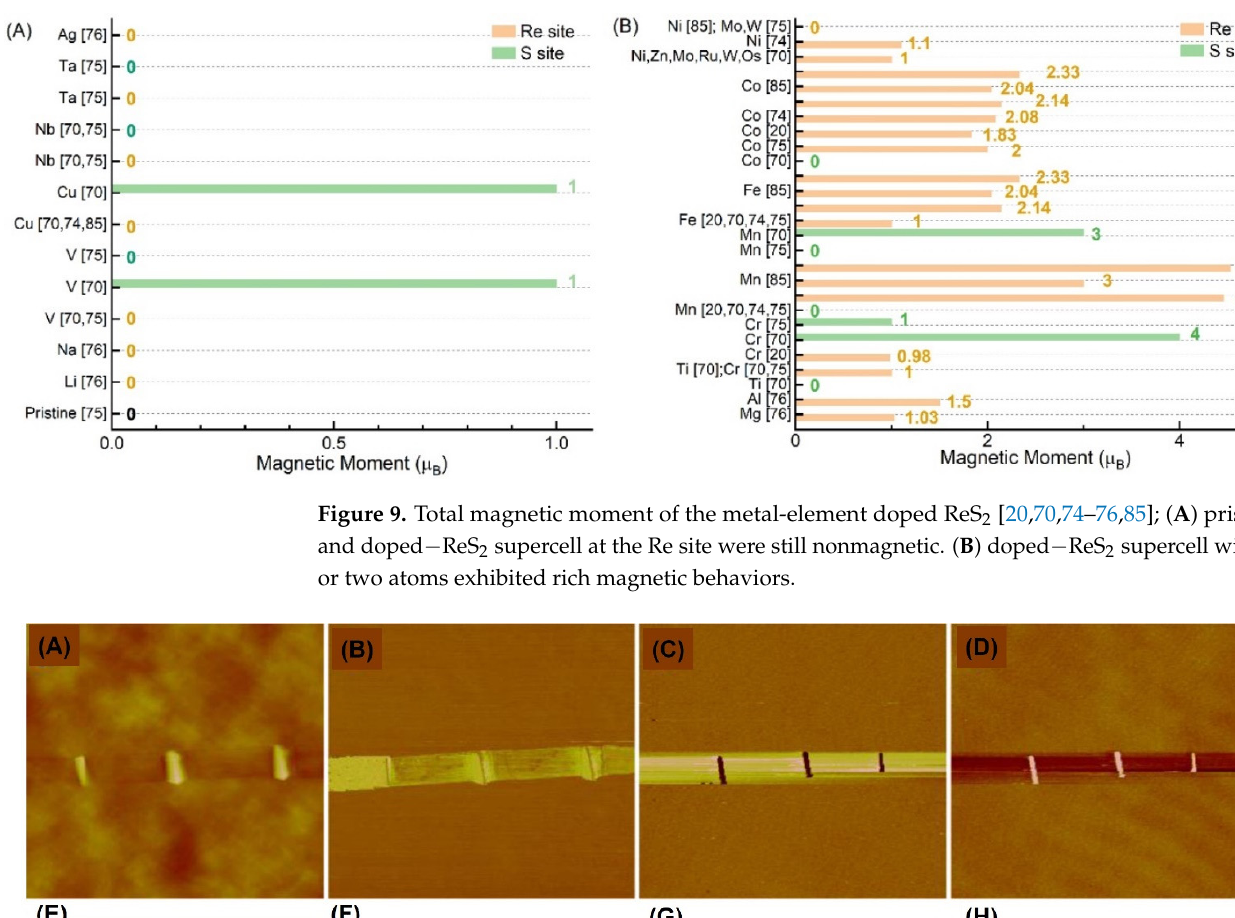
Figure 11. Ferromagnetism of ReS 2 thin films. ( A ) M − H curves at 300 K. Scale bar: 50 µm. ( B − D ) M s − T , M r − T, and H c − T , respectively. ( E ) FC and ZFC curves from 2 to 400 K. ( F ) FL curves. Reprinted with permission from [27]. Copyright 2019, John Wiley and Sons. V ReS and V ReS 2 were created after buckling in Figure 10F. The saturation magnetic moment ( M s ) at RT was then found to increase from 0.219 emu/g to 0.370 emu/g, as shown in Figure 11A–B. Similarly, the magnetic moments at other temperatures also increased to various de- grees, as shown in Figure 11B. In addition, the residual magnetization ( M r ) at 5K increased by a factor of 14, as shown in in Figure 11C. However, the change in coercivity ( H c ) was more